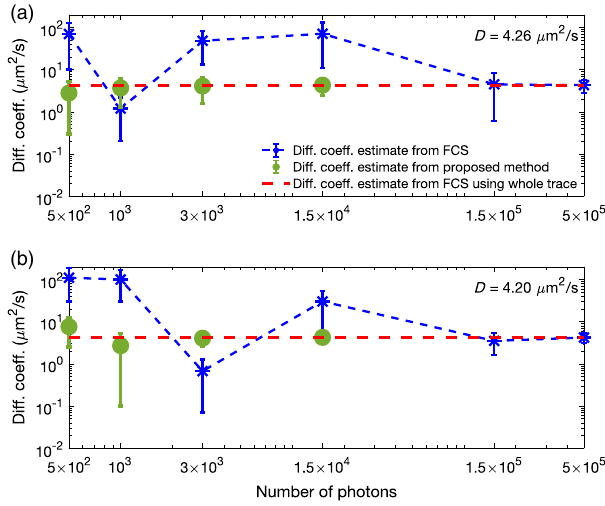
FIG. 10. Higher laser powers in experimental traces provide more photons per unit time and sharper diffusion-coefficient estimates. Estimates shown are drawn from experimental traces with high ( 100 μ W) (a) and low ( 25 μ W) (b) laser power with fixed concentration 1 nM of Cy3 dye molecules and 75% glycerol. Similarly to Fig. 1, we compare our method ’ s diffusion-coefficient estimate (circle green dots) to FCS (blue asterisk) as a function of the number of photons used in the analysis. Since by 1 . 5 × 10 4 photon arrivals our method has converged, we avoid analyzing larger traces. The red dashed line is the FCS estimate produced from the entire 5-min trace containing ≈ 3 × 10 6 photon